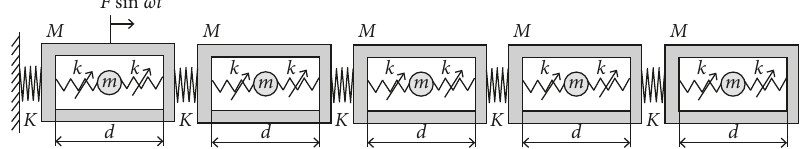
Figure 4: Effective negative mass system models of the Duffing oscillator of five different